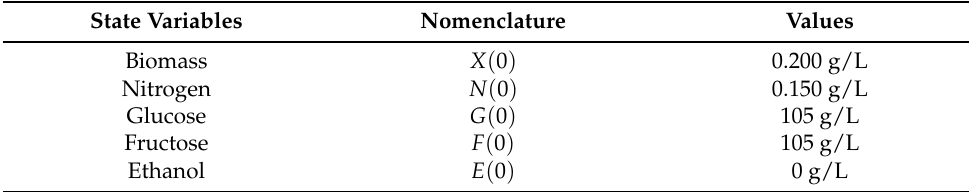
Table 1. Initial conditions for state